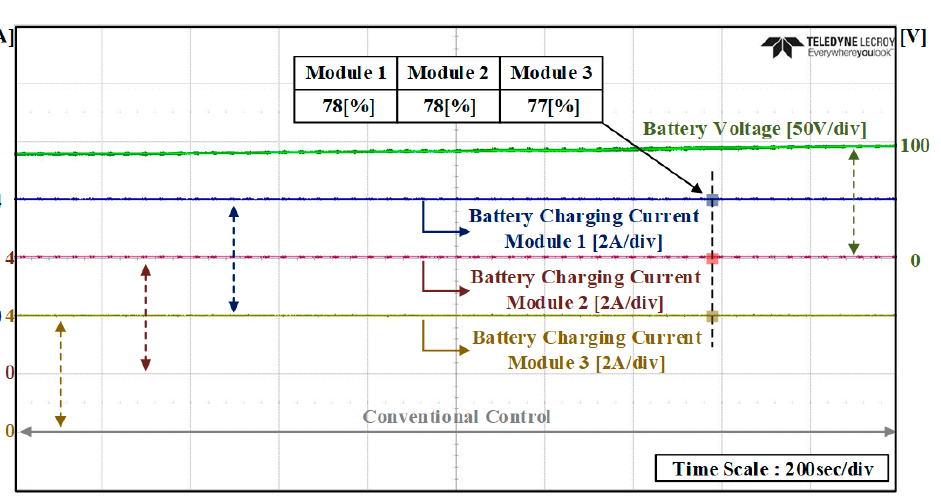
Figure 15. Current flow when modules are in the same SoC state. The voltage was 100 V, and the charging current was used at a 0.4-C rate. The battery SoC state was uniform, and the current command value was equal to 4 A according to each module SoC. Figure 16 shows the experimental waveform for selective charging according to SoC, and Figure 17 shows the charging current flow according to Figure 16.